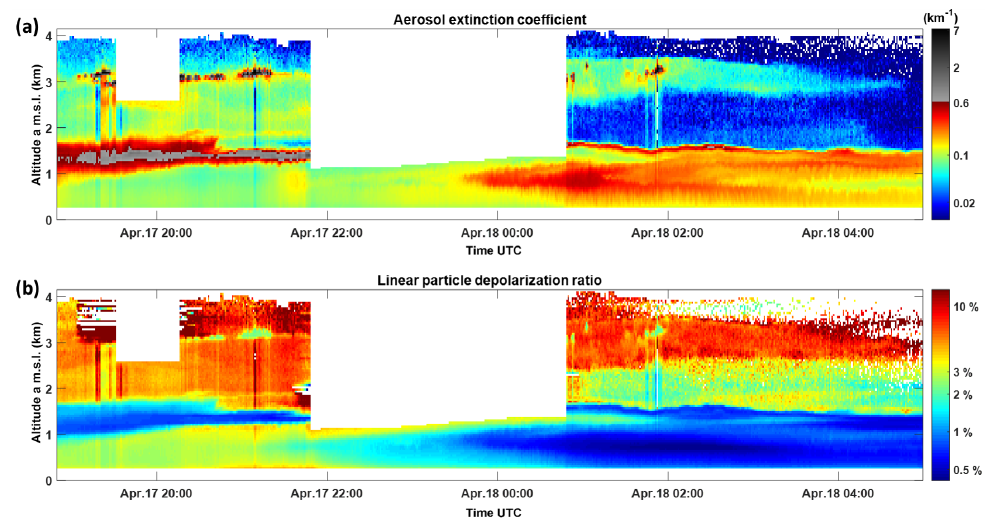
Figure 9. Time series, from 17 April at 18:50UTC to 18 April at 05:00UTC, of the profiles of (a) aerosol extinction coefficient (AEC), and (b) linear particle depolarization ratio (PDR). The PDR is only considered for AEC >0.01km − 1 .